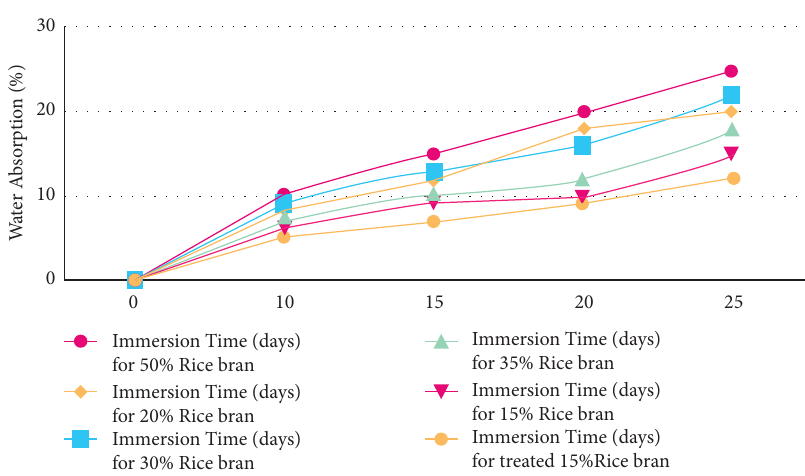
Figure 4: Water absorption test result for rice bran PLA Table 5: Termogravimetric analysis of rice bran PLA composite.